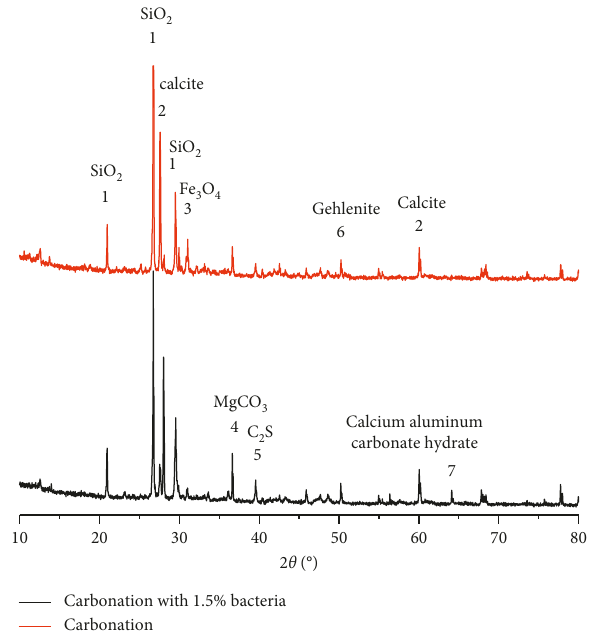
Figure 9: XRD patterns of mineralized steel slag.